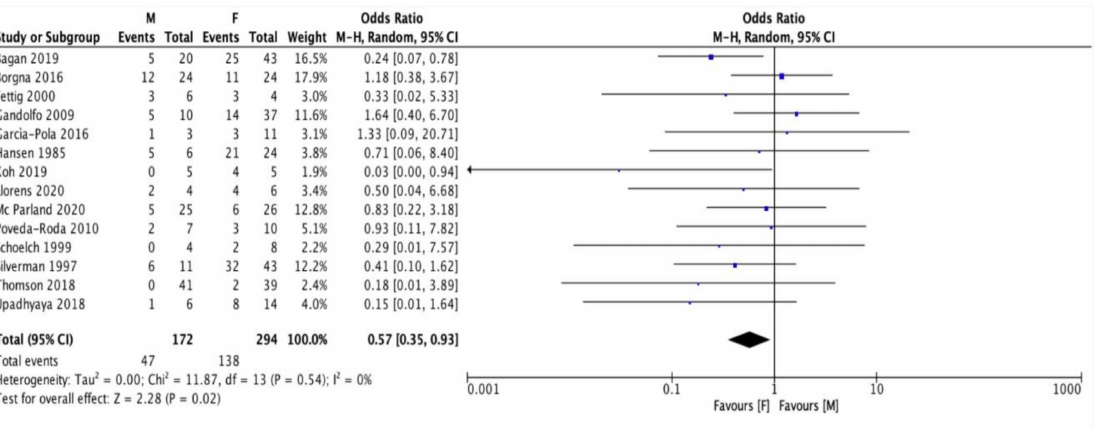
Figure 2. Forest plot relating to the prevalence of neoplastic events in male (M) and female (F)